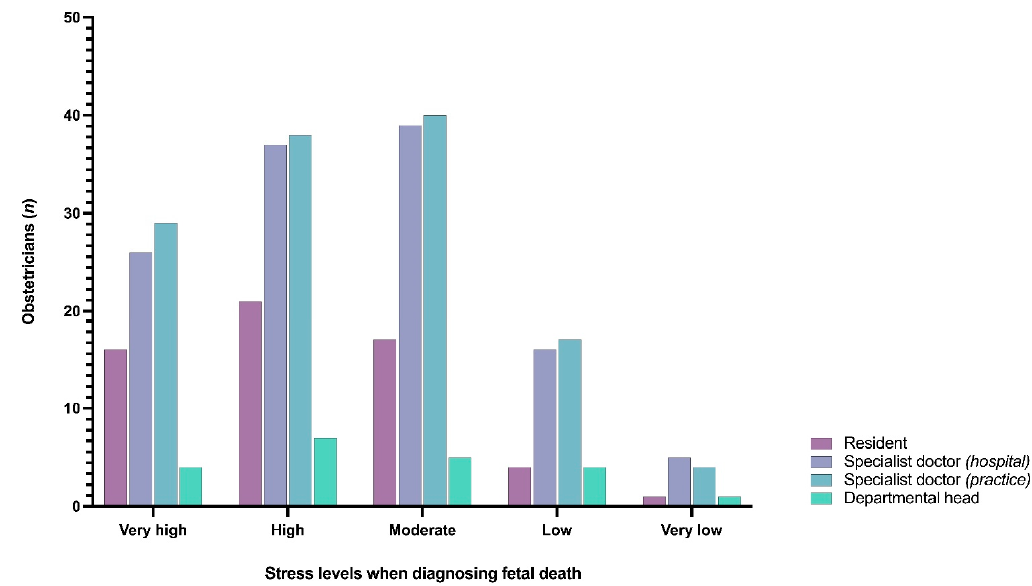
Figure 2. Clustered bar chart on stress levels (i.e., very high; high; moderate; low; very low) in obstetricians when diagnosing fetal death.